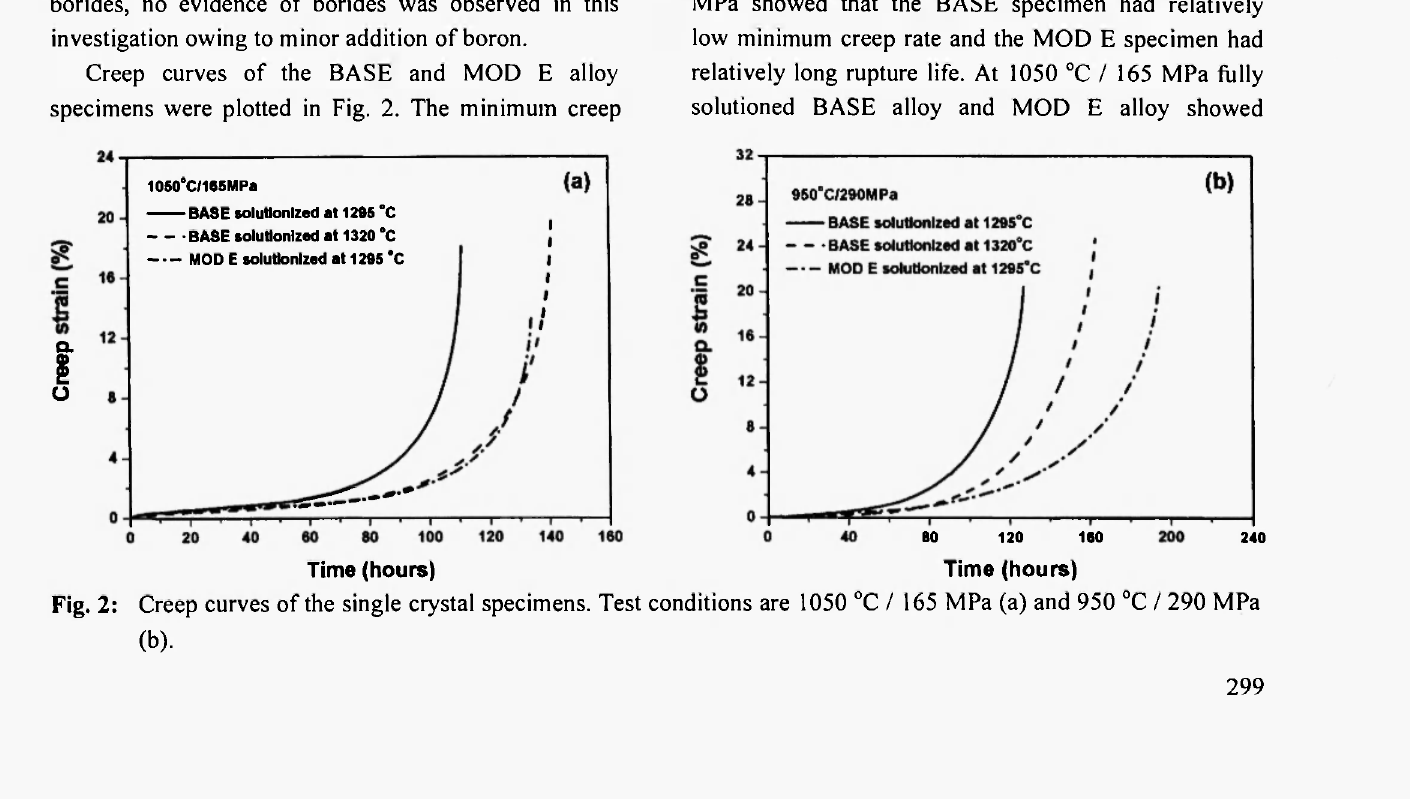
Fig. 1: Micrographs of heat-treated BASE alloy [(a), (b)] and MOD Ε alloy [(c), (d)]. (a) and (c) are optical micrographs, and (b) and (d) are SEM micrographs. rate was calculated from the curves and listed in Table 3 in conjunction with the rupture lives and rupture